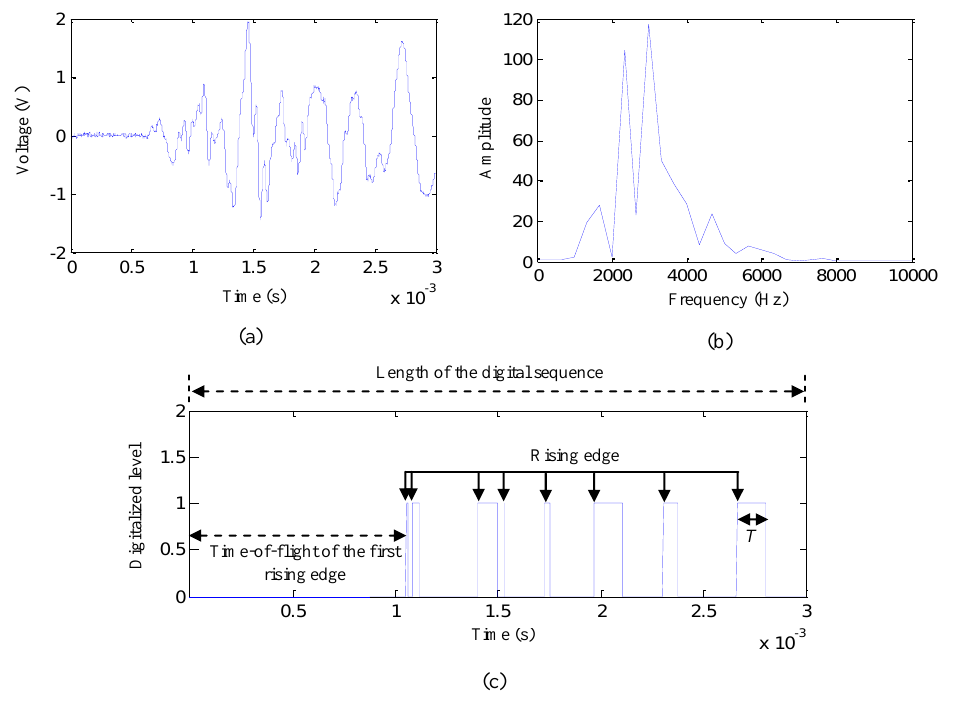
Figure 5. Typical impact response signal of PZT and the digital sequence. ( a ) Impact response signal of PZT3; ( b ) Frequency spectrum; ( c ) Digital sequence of impact response signal of PZT